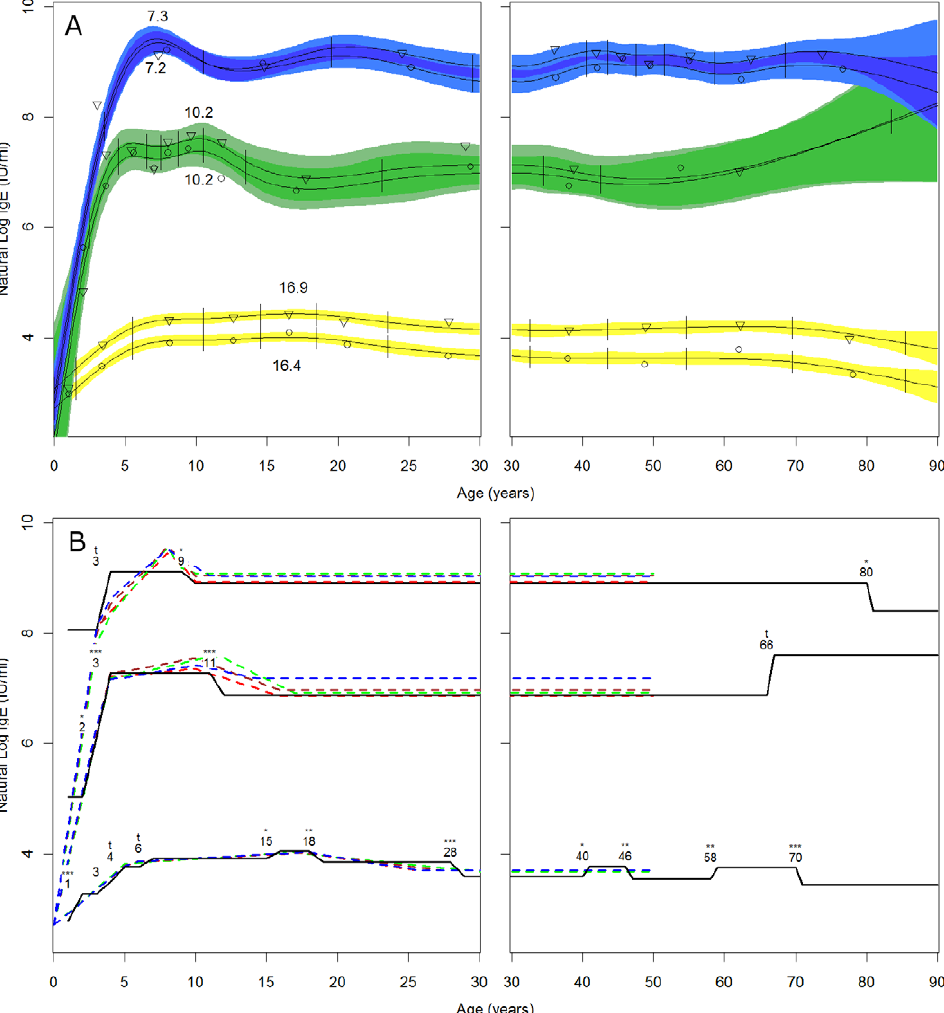
Figure 2. Models for IgE by age in Tsimane, Shuar, and NHANES. A) Generalized additive models for Tsimane (top, blue), Shuar (middle, green), and NHANES (bottom, yellow). Points show the mean lnIgE value for males (triangles) and females (circles) between knots specified in the initial model basis (vertical lines), while lines indicate the thin plate regression spline for each sex. For all three populations males have the higher fit line. Numbers indicate the estimated ages at which the initial peak in IgE occurs. Shading indicates local 95% confidence intervals for the spline, with dark areas indicating overlap between male and female confidence intervals and light areas indicating no overlap. B) Ordinal step models and non- linear regression models. Ordinal model parameters were entered in stepwise fashion according to AIC minimization, resulting in the final models. Numbers indicate a significant transition at greater than the age given, symbols the significance of the parameter in the model: t p # 0.10, * p # 0.05, ** p # 0.01, *** p # 0.001. Dashed lines indicate the model fits for non-linear models, including the population specific models in Table 3 (red), and the interaction models in Table 4 (Model 1 in green, Model 2 in brown, and Model 3 in blue). For simplicity only the models for females are shown.